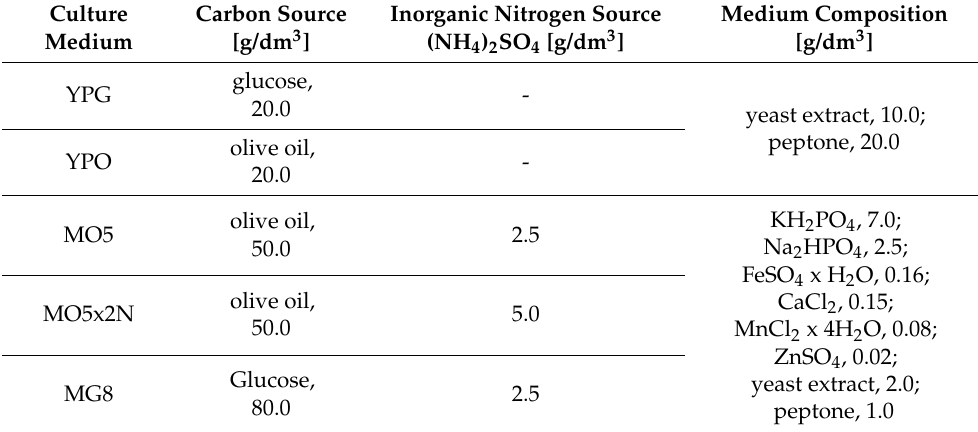
Table 1. Culture media in bioreactor